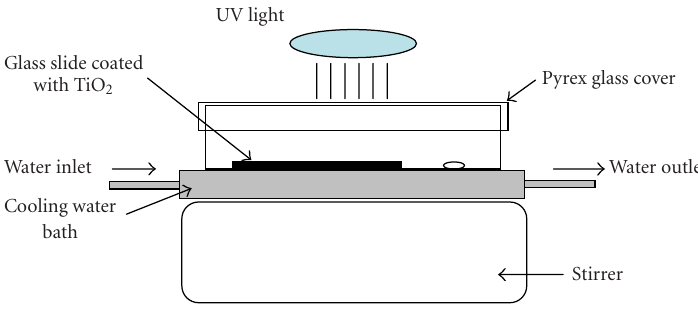
Figure 2: Schematic diagram of photoreactor for degradation of diazo